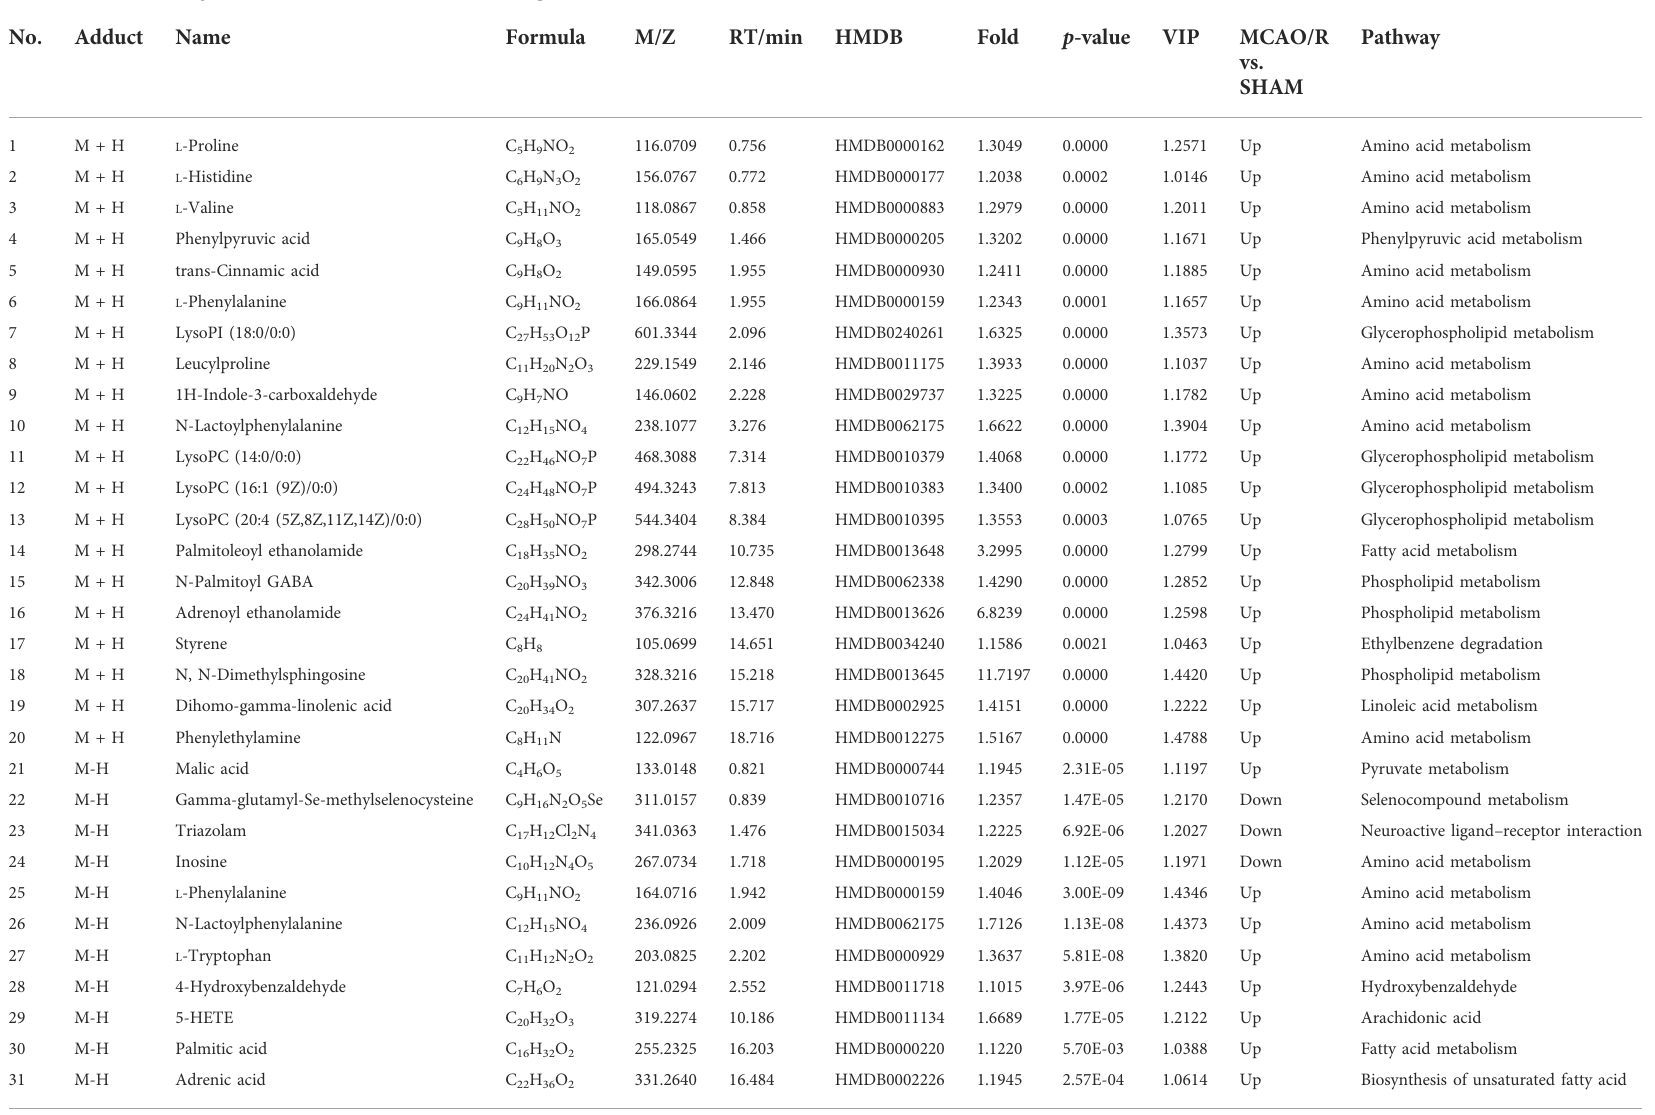
TABLE 2 Statistical analysis results of identi fi ed metabolite changes in the brain.